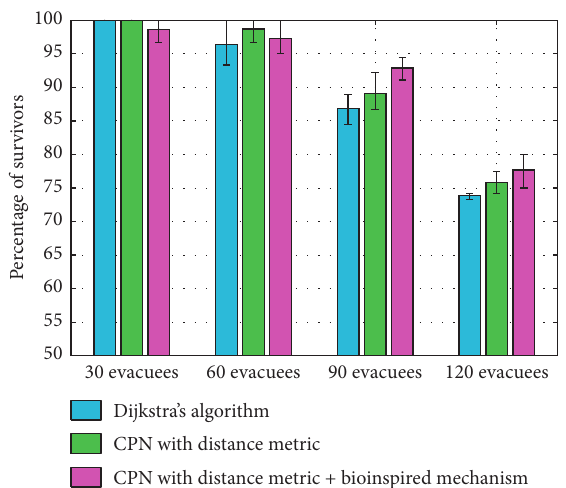
Figure 4: The percentage of survivors in the Imperial College’s EEE building model for each scenario. The results are the average of five randomized simulation runs, and error bars show the min/max result in any of the five simulation